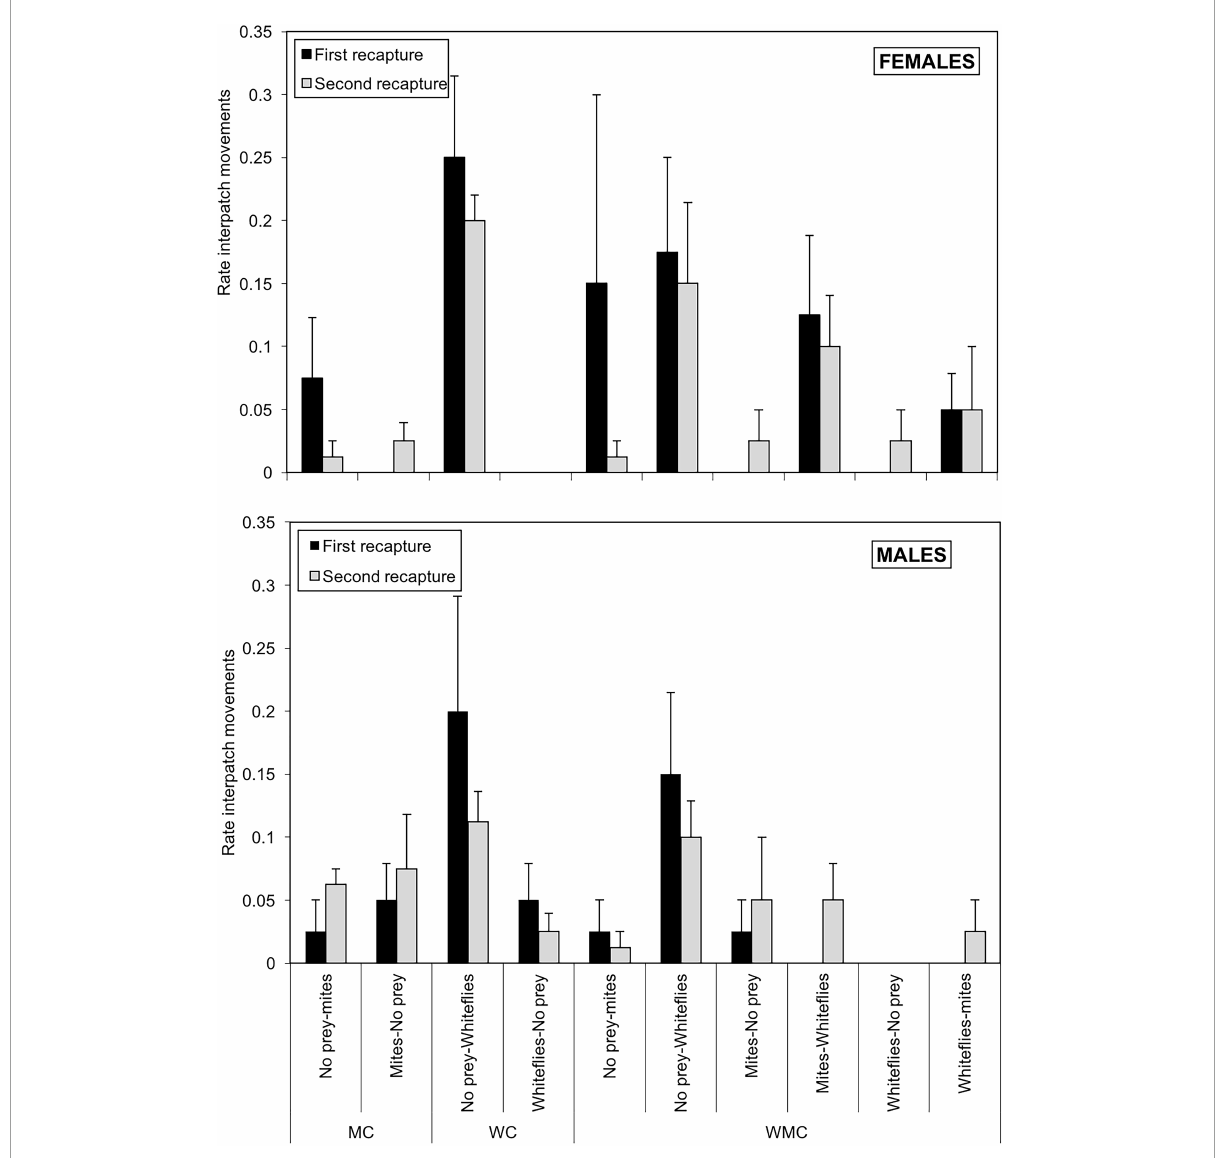
FIGURE7 Interpatch movement rates of females (upper graph) and males (lower graph) of D. hesperus per plant with standard errors, in three habitats (MC, WC, and WMC) composed by patches with different food resources (No prey- C-, mites- M-,